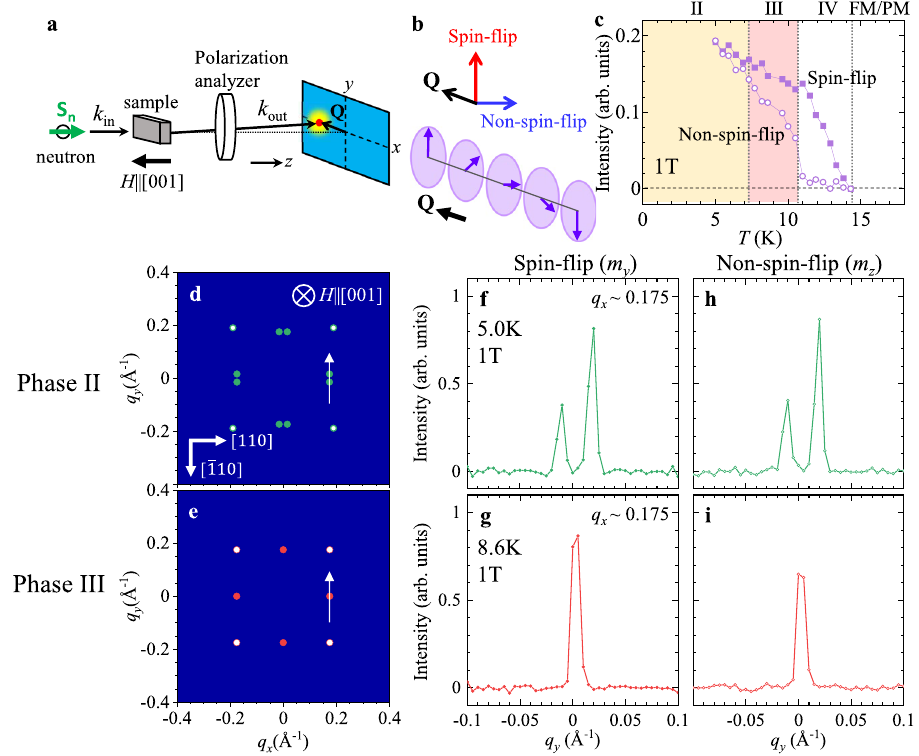
Fig. 4 Polarized SANS study of the modulated magnetic states. a , b Schematic illustration of ( a ) experimental setup and ( b ) the magnetic scattering selection rules. S n represents the direction of the neutron polarization, which is aligned parallel or antiparallel with k in || [001]. Only a modulated spin component ^ m Q ð Þ normal to Q can give rise to magnetic neutron scattering. In this setup, spin- fl ip (SF) scattering arises due to the in-plane component of ^ m Q ð Þ perpendicular to both Q and S fl ip (NSF) scattering arises due to the out-of-plane component of ^ m Q ð Þ parallel to n || [001] (red arrow), and non-spin- S n || [001] (blue arrow). c Temperature variations of the scattering intensity of SF and NSF channels at 1 T. d , e Schematic illustration of SANS patterns for phases II and III. The arrows indicate the line-scan directions of ( f – i ). f – i Line-scan pro fi les for ( f , g ) spin- fl ip and ( h , i ) non-spin- fl ip channels measured in phases II and III at 1 T, which detect in-plane and out-of-plane component of ^ m Q ð Þ (i.e. ^ m y Q ð Þ and ^ m z Q ð Þ ), respectively. Here, the scattering intensity is integrated for the range of q x = 0.175 ± 0.005 Å -1 . The asymmetry of two peak intensities in phase II ( f , h ) is probably due to different populations of the two equivalent magnetic